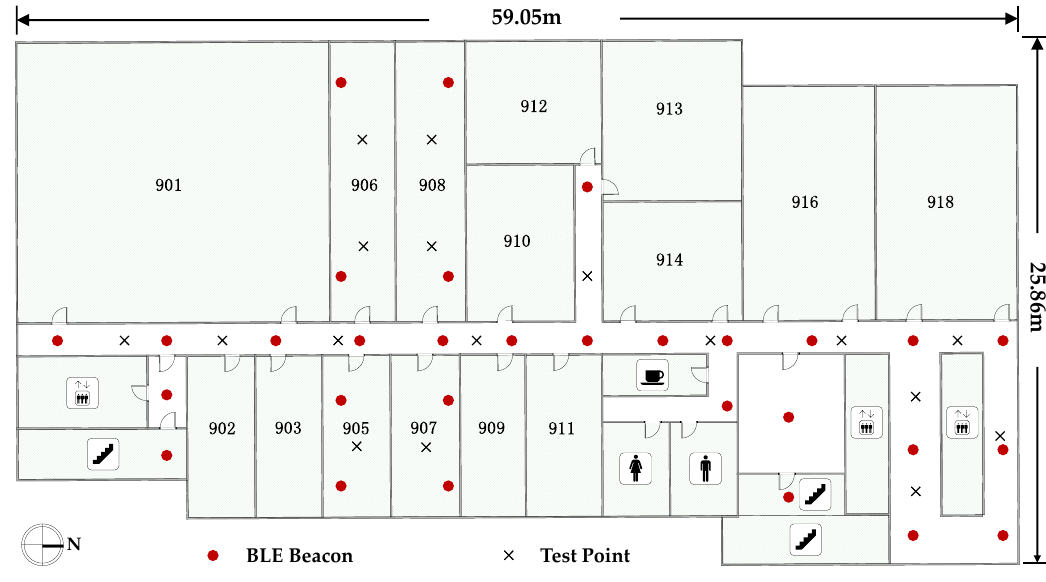
Figure 10. Experimental environment for Test bed 2.